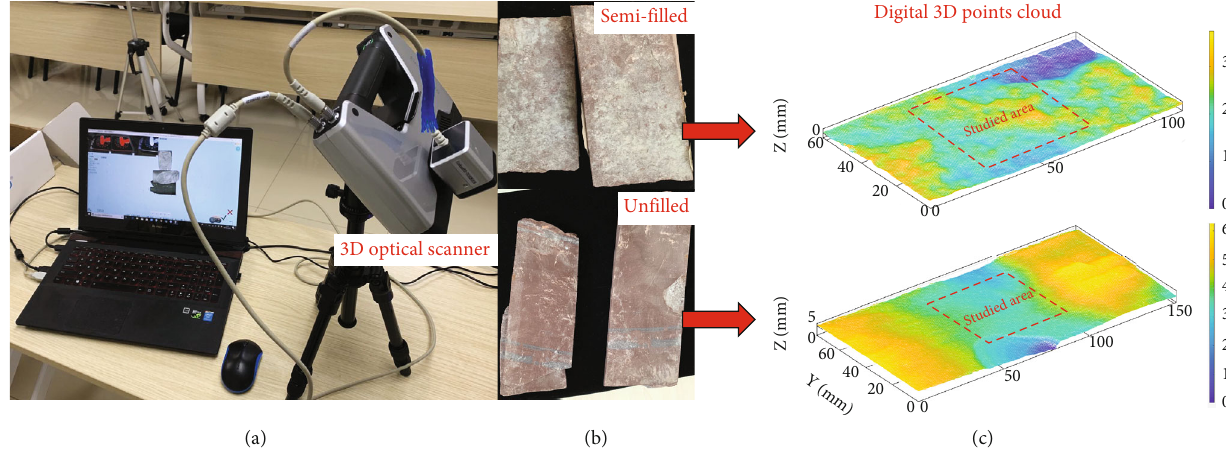
Figure 1: Basic process for acquiring the digital geometry of natural rock joints: (a) 3D optical scanner; (b) selected natural rock joints; (c) acquired digital 3D points cloud.